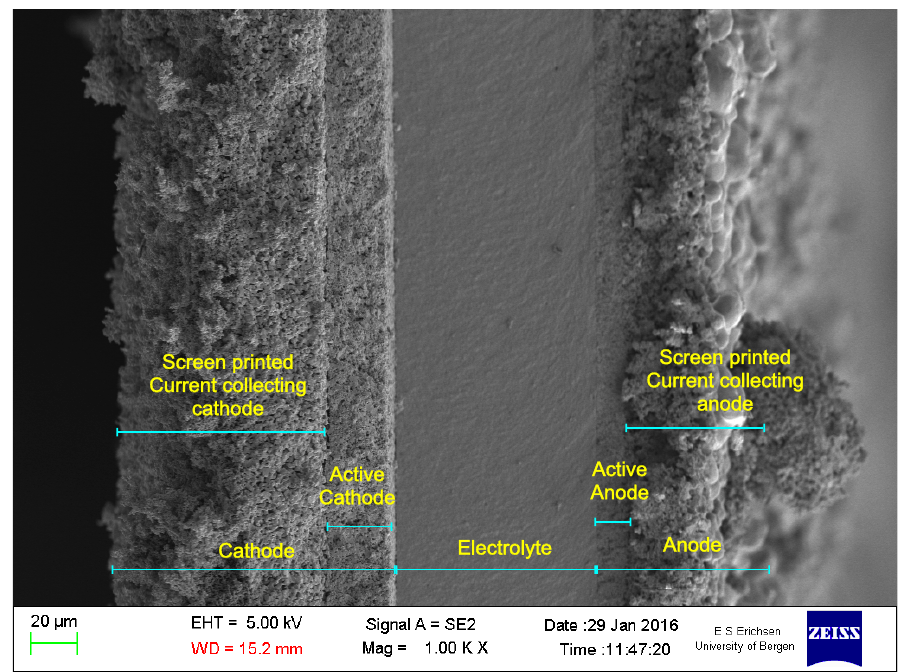
Figure 5. Cross-sectional SEM image of the entire cell operated at 850 ◦ C, after a short-term degradation